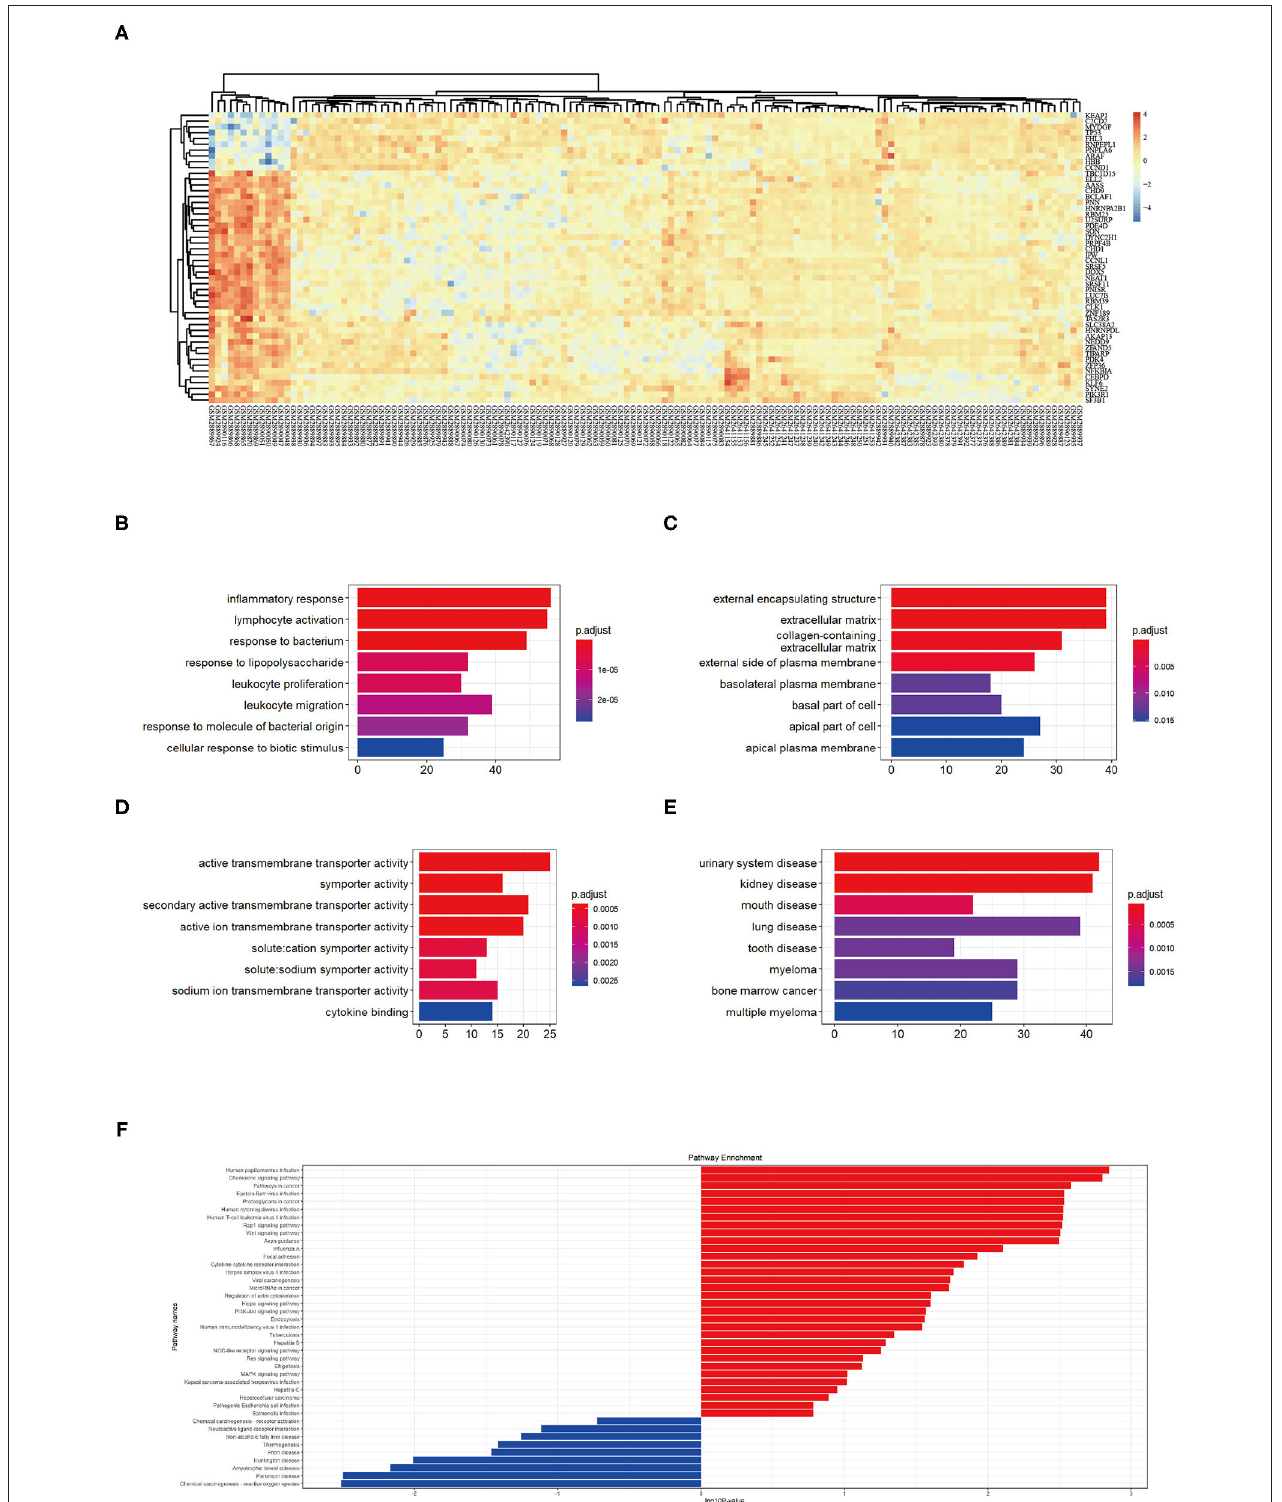
FIGURE 2 | (A) Top 50 DEG expressions in each sample, red represents a high level of expression and blue represents a low level of expression. (B–D) GO enrichment in biological process (BP), cellular component (CC), and molecular function (MF): color represents the P -value, red represents a low P -value and blue represents a high P -value. (E) DO enrichment: color represents the P -value, red represents a low P -value and blue represents a high P -value. (F) KEGG pathway enrichment results, red represents up-regulated pathways and blue represents down-regulated pathways.